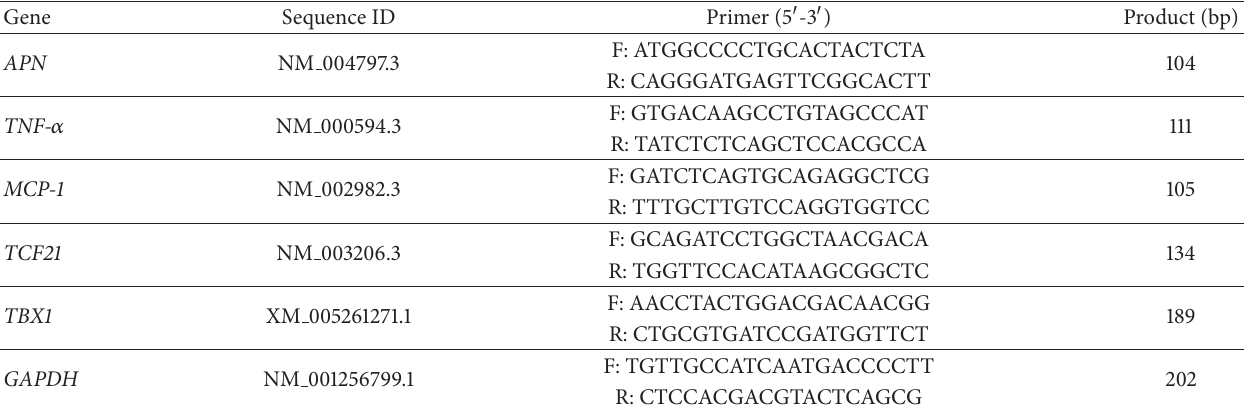
Table 1: Primers used in